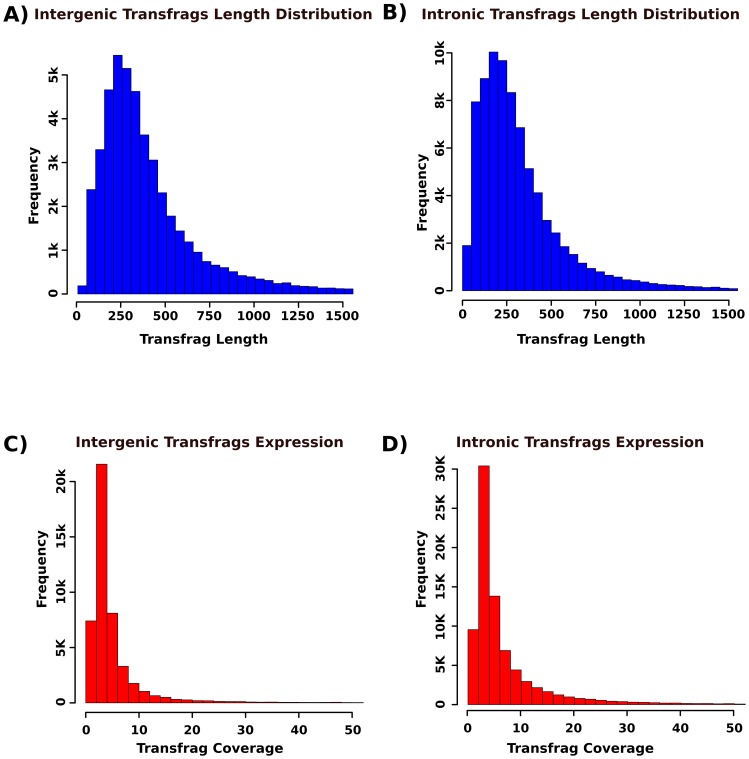
Histogram showing intergenic and intronic fragment lengths (A and B) and distribution of expression (C and D panel).